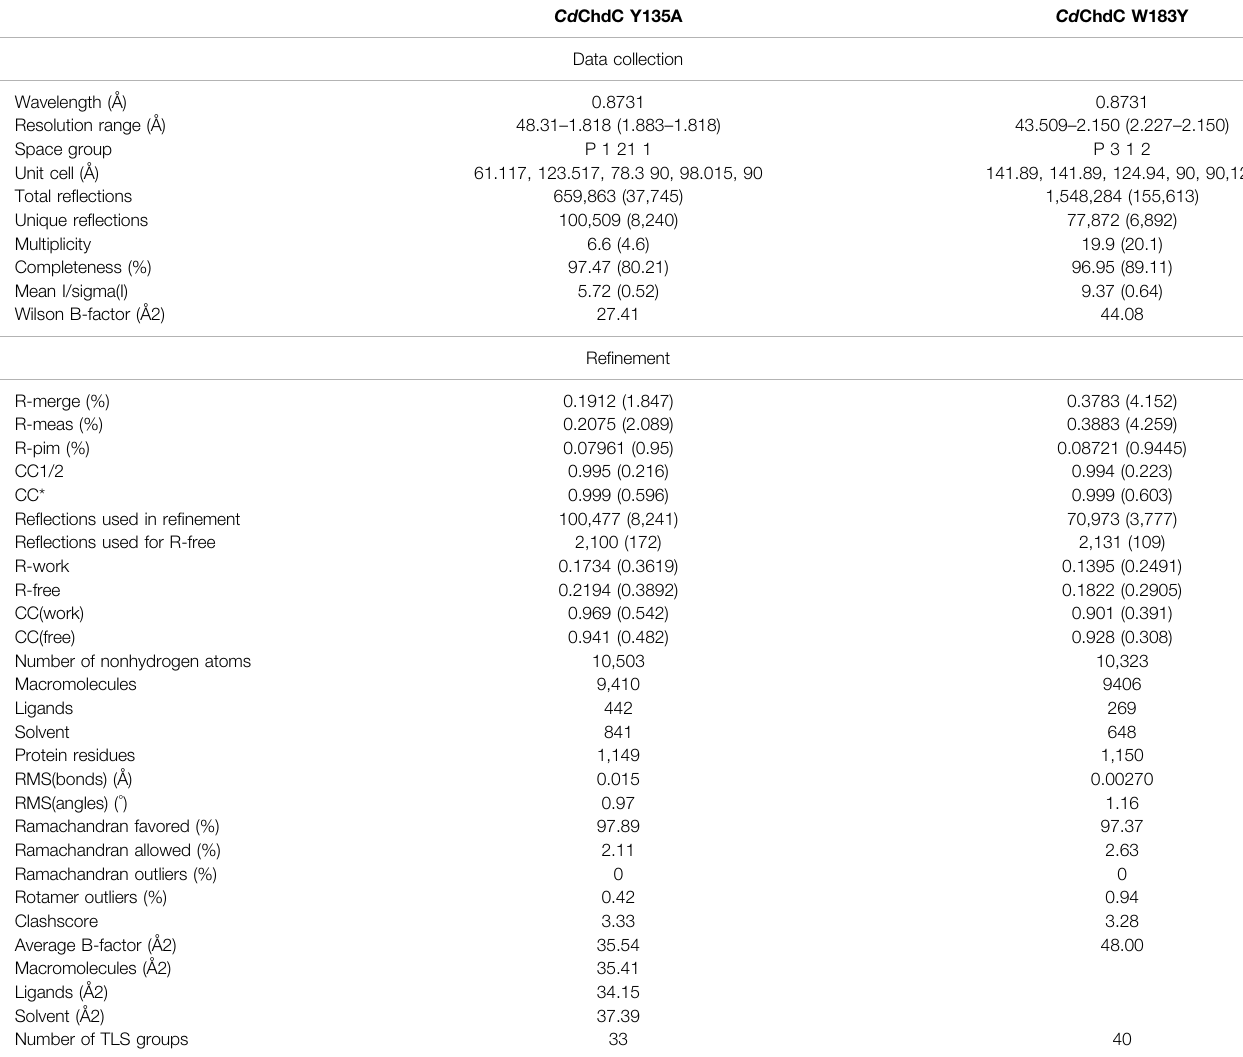
TABLE 1 | Data collection and re fi nement statistics a .